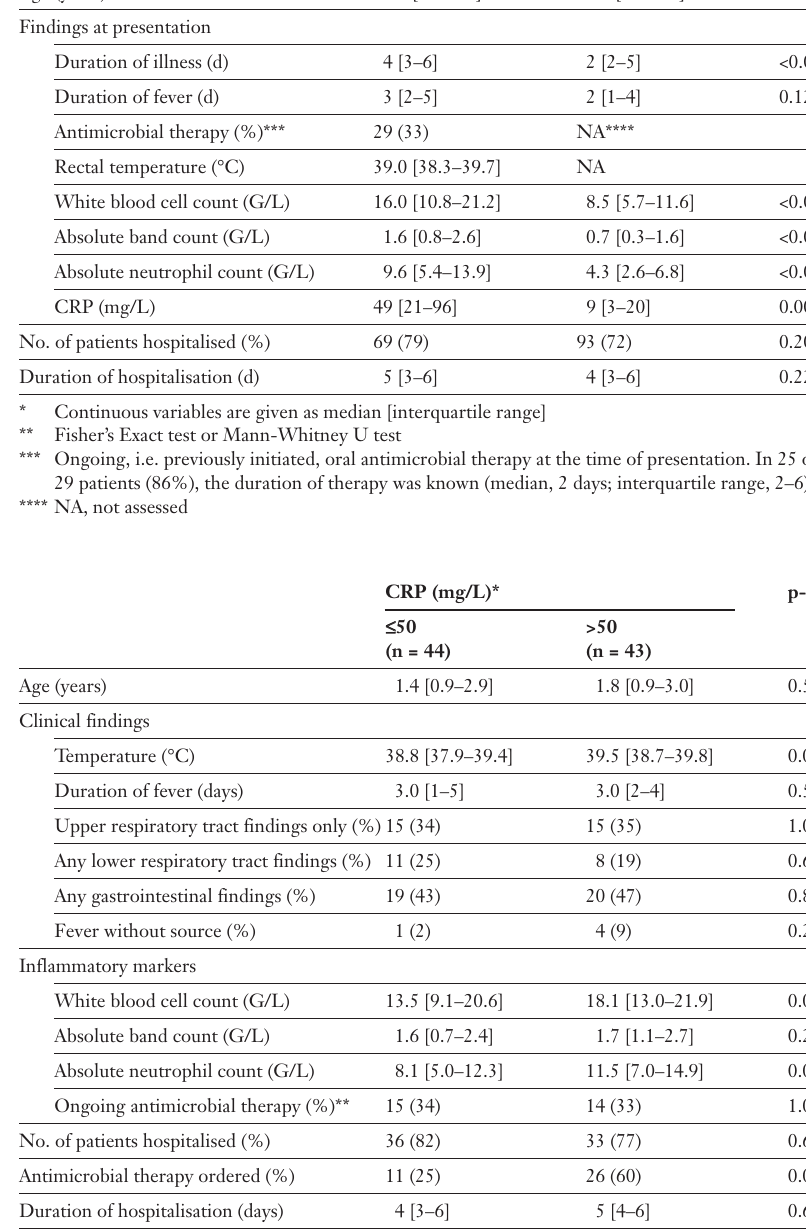
Clinical and labora- tory parameters in children with aden- ovirus or influenza virus infection at the time of presentation in the Emergency Department.